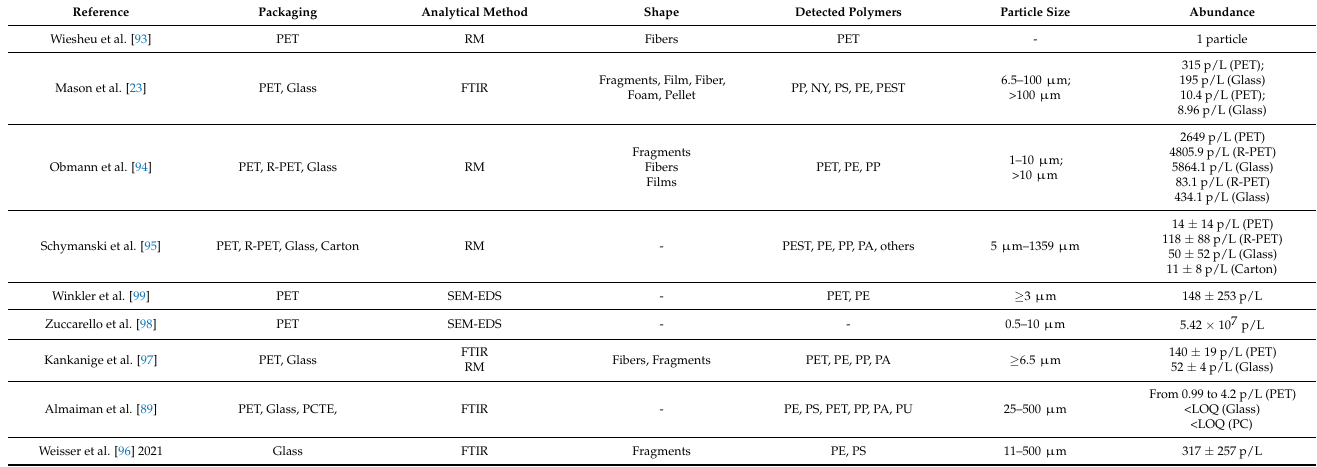
Table 1. Analytical methods, characteristics, and abundance of MPs detected in bottled water, PET (single-use and reusable), glass and carton. PE: polyethylene; PP: polypropylene; PS: polystyrene; PET: polyethylene terephthalate; PEST (PES—polyether sulfone + PET); PA: polyamide; PBN: 1- pyrenebutyric acid N-hydroxysuccinimidyl ester; PU: polyurethane; PCTE: polycarbonate track-